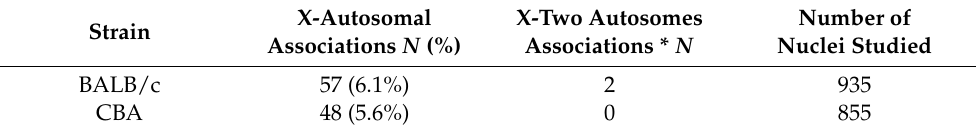
Table 1. Associations between X chromosome and autosomal bivalents in two inbred mouse